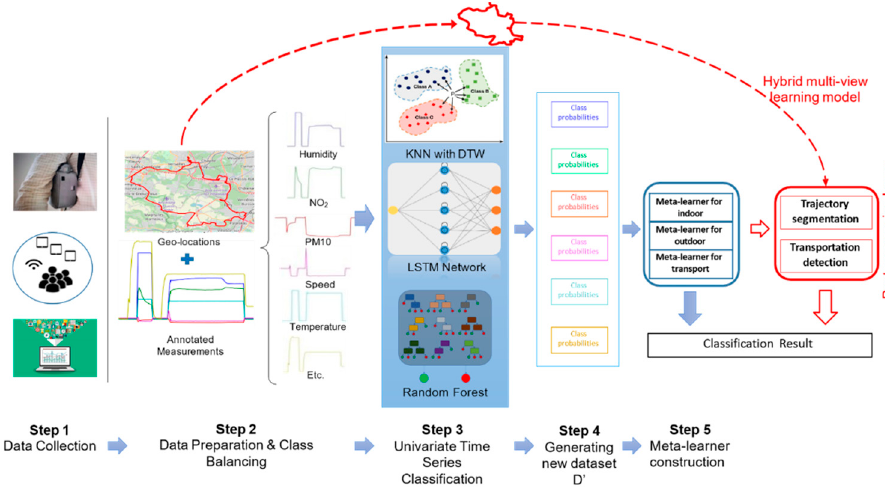
Figure 1. Overview of the environment recognition process. Table 2. Input raw data of the meta-learner. This example shows the output of the first-level learners on four views (temperature, humidity, speed, and NO 2 ), the predicted environment, and the probability. For instance, the first-level learner predicted “transport” with a probability of